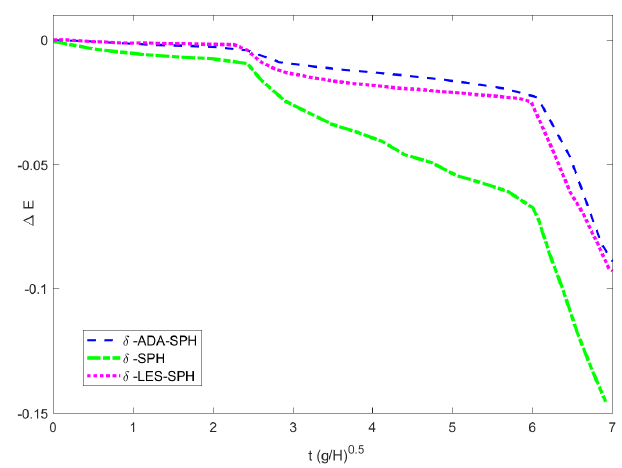
Figure 17. Two-dimensional dam-break flow: Time evolution of mechanical energy. The blue dashed line shows the results obtained by the present δ -ADA-SPH scheme. The magenta dotted line presents the results obtained with the δ -LES-SPH approach. Finally, the green dash-dot line presents the results obtained in [25] using δ -SPH scheme. All the results are computed with H / ∆ x 0 =